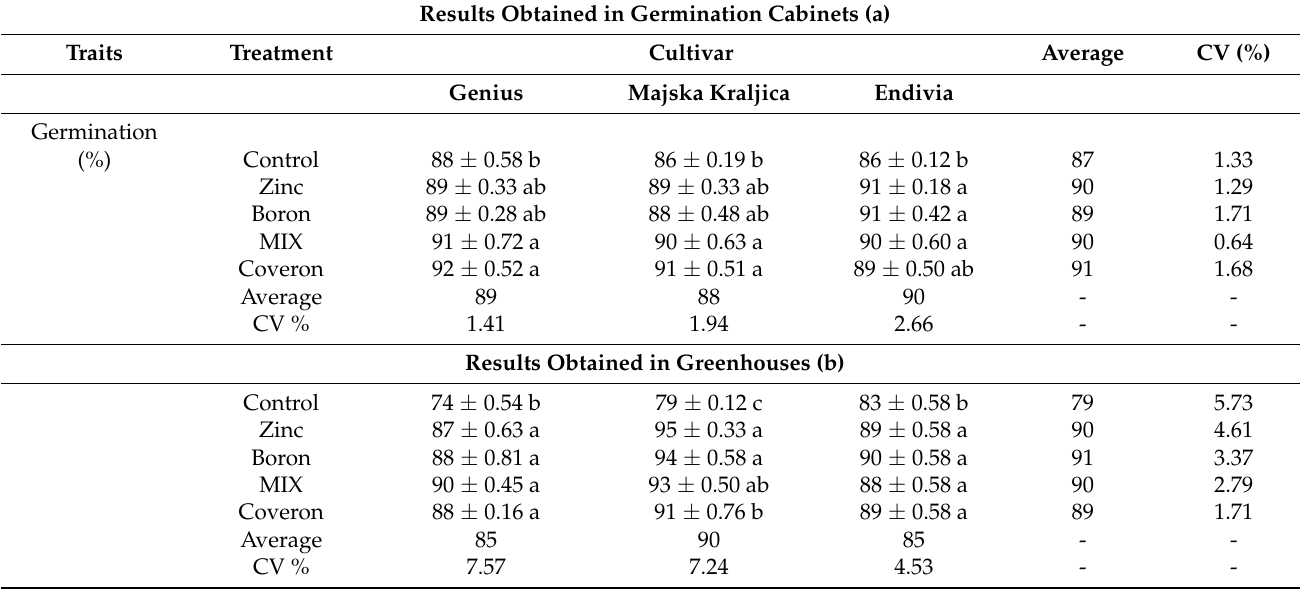
Table 1. Germination after treatments applied to lettuce